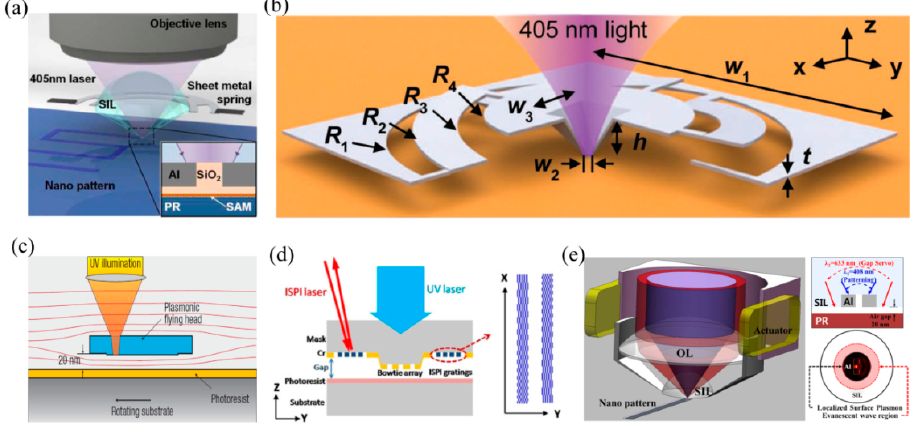
Figure 20. ( a ) Local plasmonic lithography system with a contact probe on a metal spring; ( b ) Schematic view of metal spring; ( c ) Cross-section schematic of the plasmonic head flying above the high-speed rotating substrate; ( d ) Schematic diagram of the nanolithography setup with ISPI gratings; ( e ) Schematic of the plasmonic optical head. Reproduced from (a), [86], Copyright © 2009, OSA; (b), [66], Copyright © 2012, WILEY; (c), [27], Copyright © 2008, NPG; (d), [87], Copyright © 2014, Springer; (e), [88], Copyright © 2012,